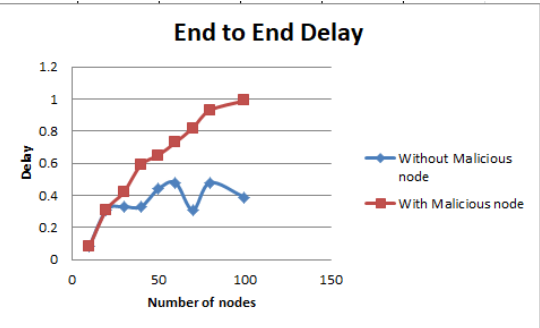
Table 25:- Average End to End